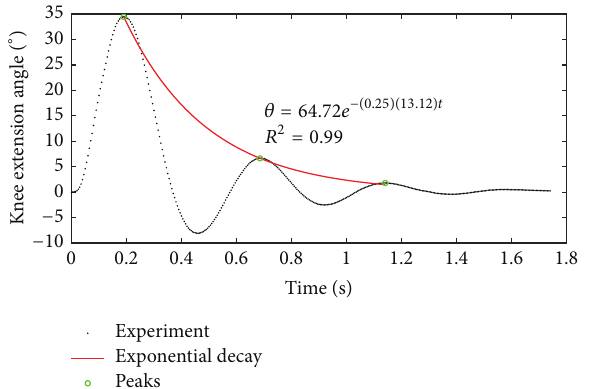
Figure 2: Ranges of the exponential decay rate and damped natural frequency determined for the sample